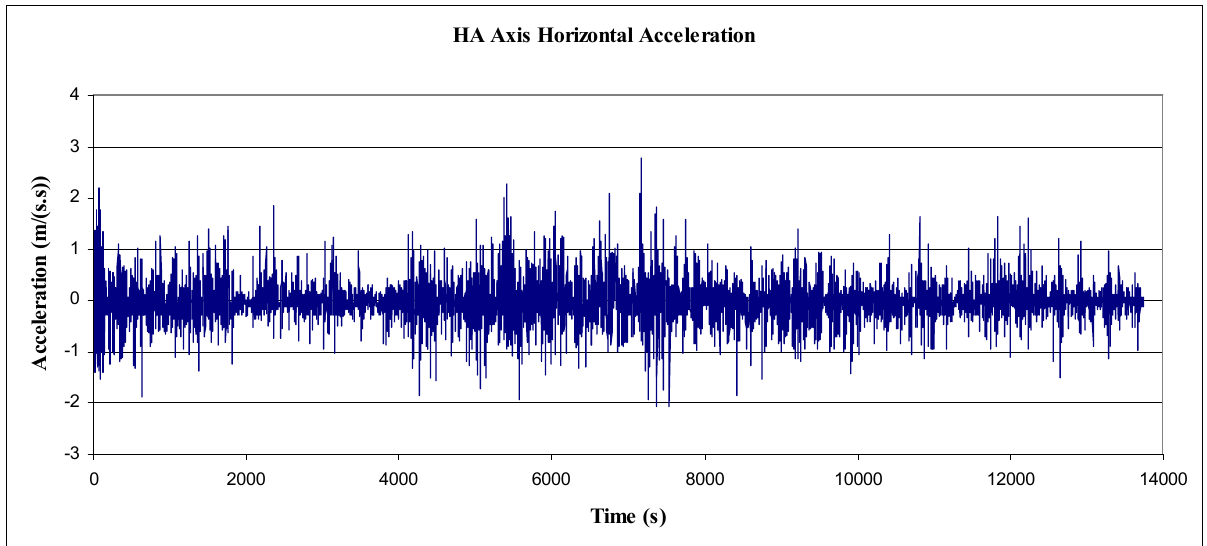
Figure 7. HA Axis Acceleration, as recorded by an